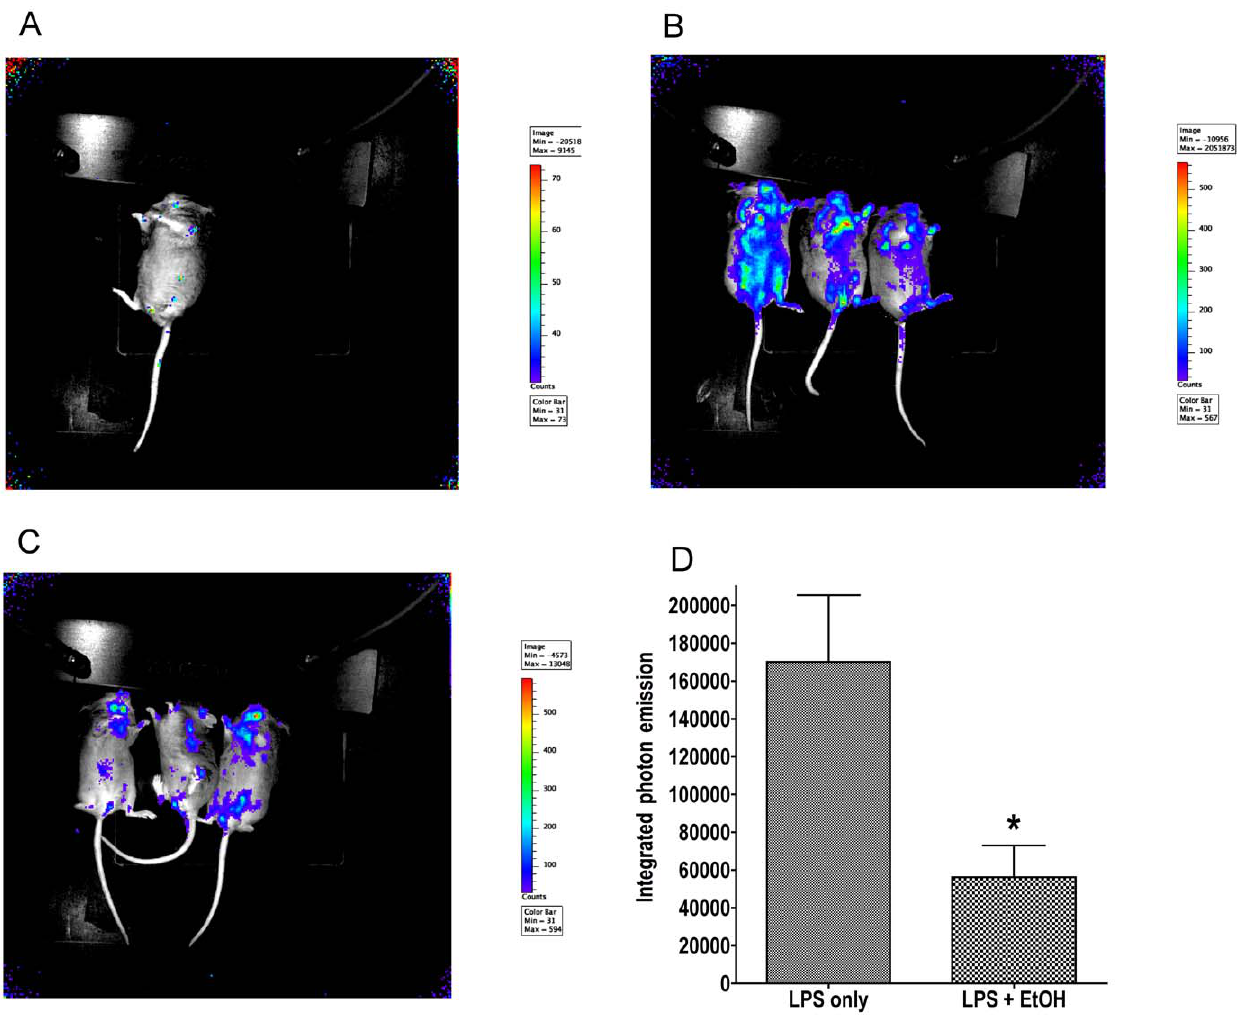
Figure 2. Comparison of NF- k B expression in reporter mice treated with LPS alone or ethanol and LPS. A For the naive mouse, luminescence was 1.627 6 10 4 CCD camera counts. B In the group treated with LPS only, 2.406 6 10 5 counts were measured for mouse one, 1.347 6 10 5 counts for mouse two, and 8.485 6 10 4 counts for mouse three. C In the group treated with LPS + 86.8 mM EtOH, 4.754 6 10 4 counts were measured for mouse one, 3.213 6 10 4 for mouse two, and 8.869 6 10 4 for mouse three. D Mice treated with 6 g/kg ethanol before LPS showed significant reduction of luminescence (*=LPS plus EtOH vs. LPS only: P , 0.05).